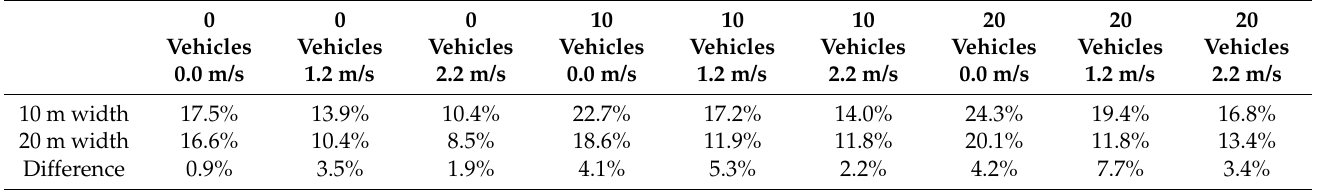
Table 6. Mean percentage of T WA increase in north–south canyons, compared with east–west canyons as a